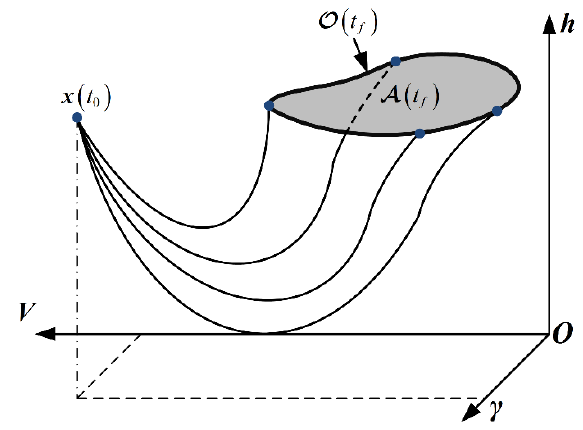
Figure 2. Illustration of the aerocapture attainability set in state space. In this paper, the attainability set consists of only the terminal states of the vehicle exiting the atmosphere after aerocapture. If the vehicle drops into the atmosphere and eventually collides with the planet, the terminal state is excluded from the attainability